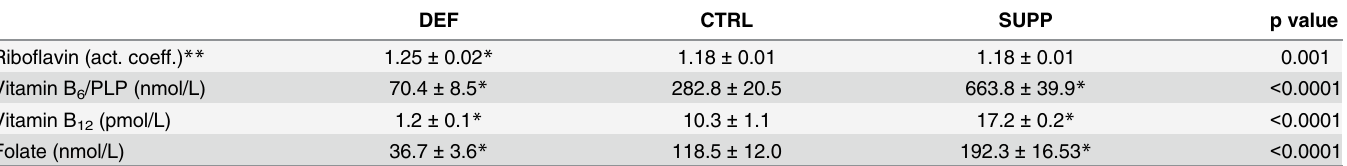
Table 2. Effect of differential B vitamin intake on blood B vitamin concentration in